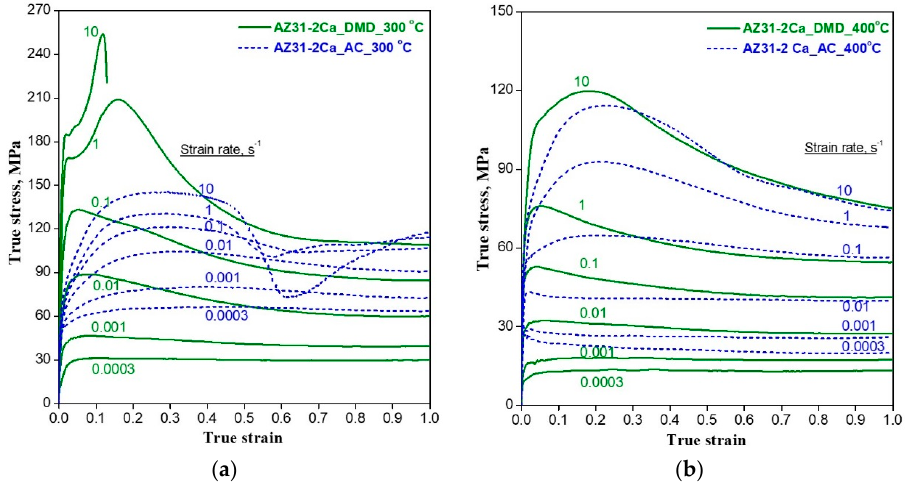
Figure 6. True stress—true strain curves obtained on DMD and AC specimens at different strain rates at temperatures of ( a ) 300 °C and ( b ) 400 °C.